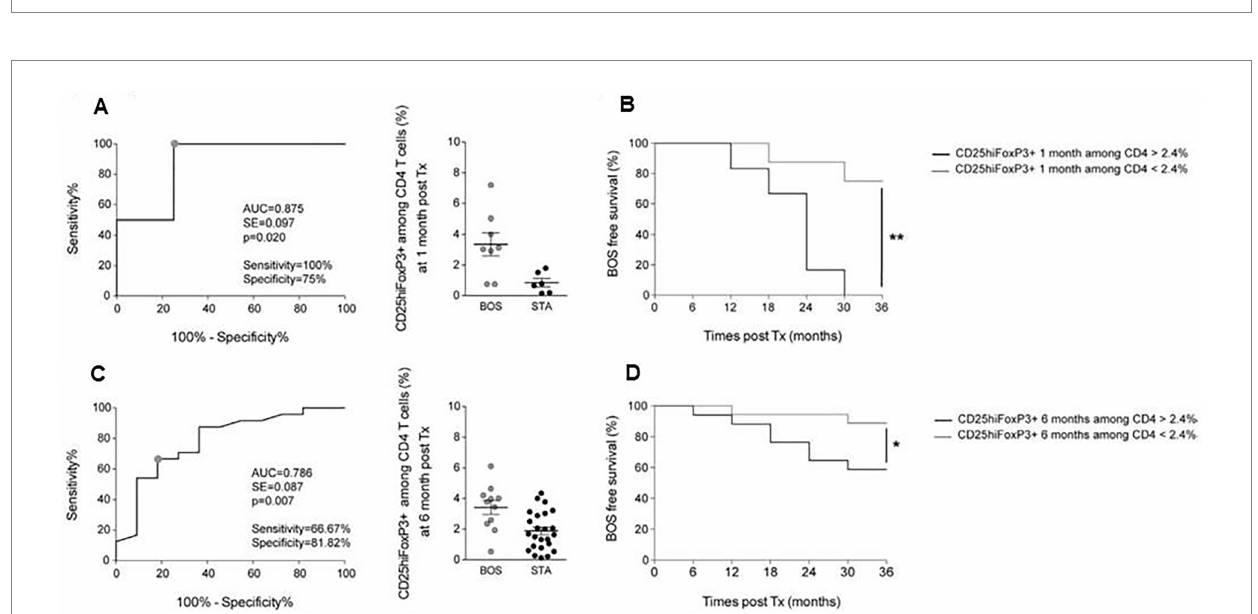
FIGURE 10 Analysis of CD4 + CD25 hi FoxP3 + T-cell proportions early post LT as a predictive biomarker of BOS development. (A) ROC curve of the proportion of CD4 + CD25 hi FoxP3 + T cells among CD4 T cells at 1 month after transplantation for BOS ( n = 8) and STA ( n = 6). (B) Kaplan–Meier analysis of BOS-free survival according to CD4 + CD25 hi FoxP3 + T-cell proportions among CD4 T cells at 1-month post-transplantation with a cut-off a t2.4% ( n = 14). (C) ROC curve of the proportion of CD4 + CD25 hi FoxP3 + T cells among CD4 T cells at 6 months post LT for BOS ( n = 11) and STA ( n = 24). (D) Kaplan–Meier analysis of BOS-free survival according to CD4 + CD25 hi FoxP3 + T-cell proportions among CD4 T cells at 6 months post-transplantation with a cut-off at 2.4%( n = 35). Results are expressed as mean ± SEM. * p < 0.05; ** p < 0.01; *** p < 0.001; **** p < 0.0001, adapted from (26).